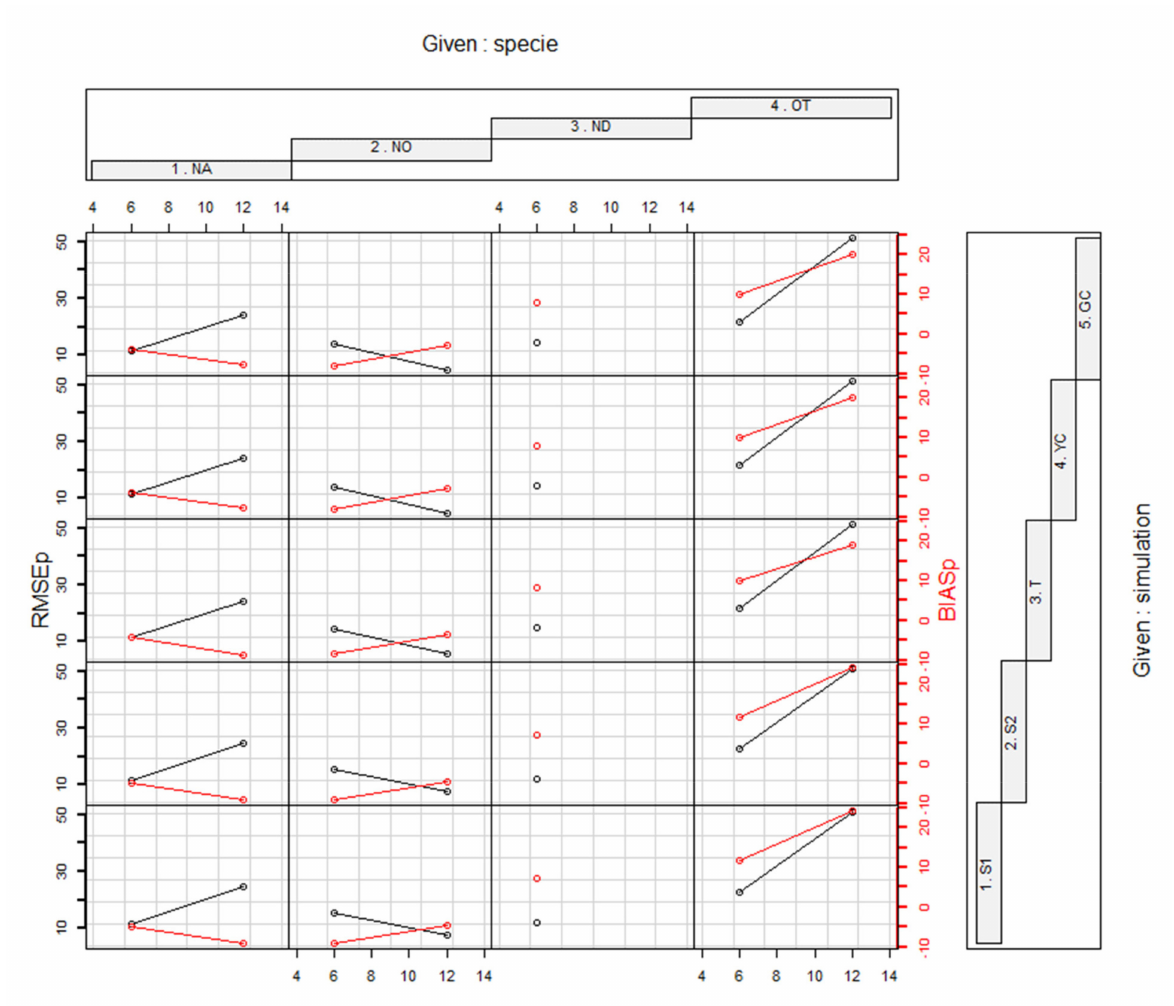
Figure 5. RMSE% (black, RMSEp) and BIAS% (red, BIASp) for number of trees (NHA, trees ha − 1 ) at 6 and 12 years of projection in second-growth RORACO forests in southern Chile. Statistics are presented by species (NA, N. alpina ; NO, N. obliqua ; ND, N. dombeyi ; OT, companion species) and by simulation model (S1, S2, T, YC, and GC, see text for